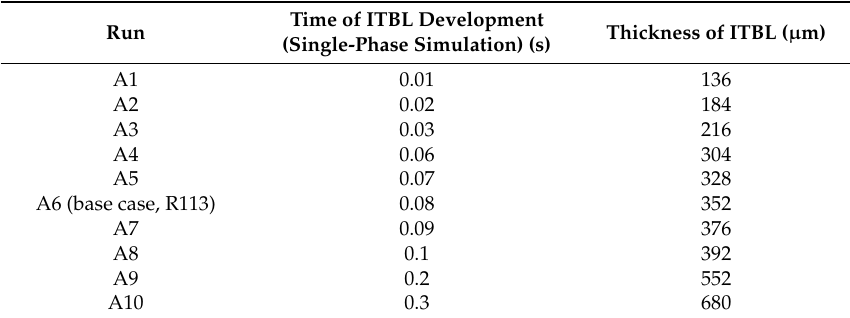
Table 4. Varied parameters in Series A of parametric numerical